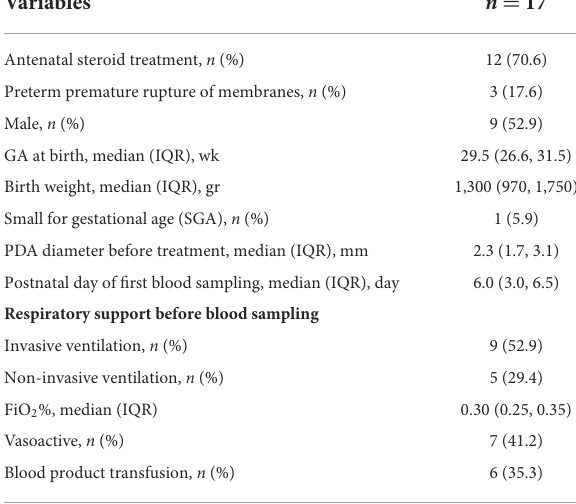
TABLE 1 Demographic and clinical characteristics of 17